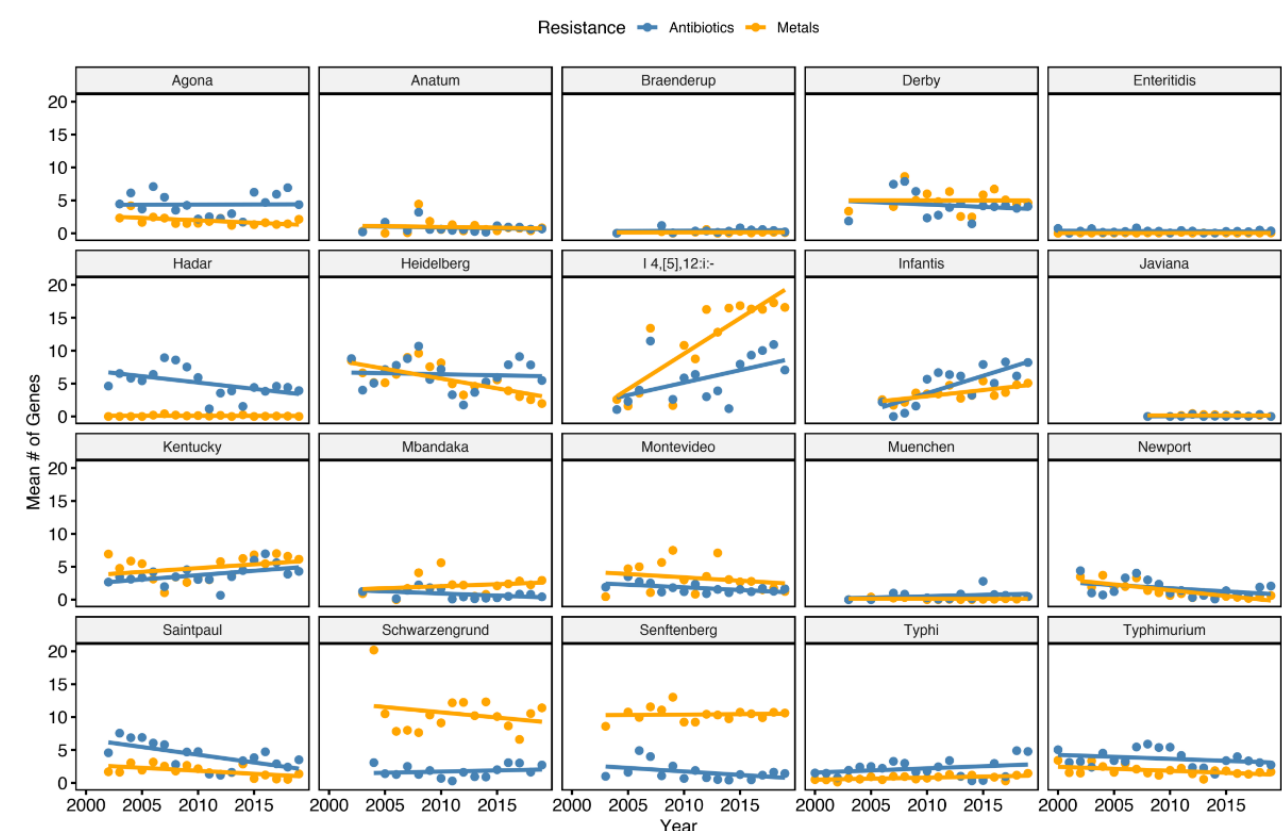
Figure 1. Temporal distribution of antibiotic and metal resistance genes by S. enterica serovar. The mean number of antibiotic and resistance homologues identified in each serovar is plotted against the date of collection. Only dates that contained n > 10 genomes were considered to control for outliers.